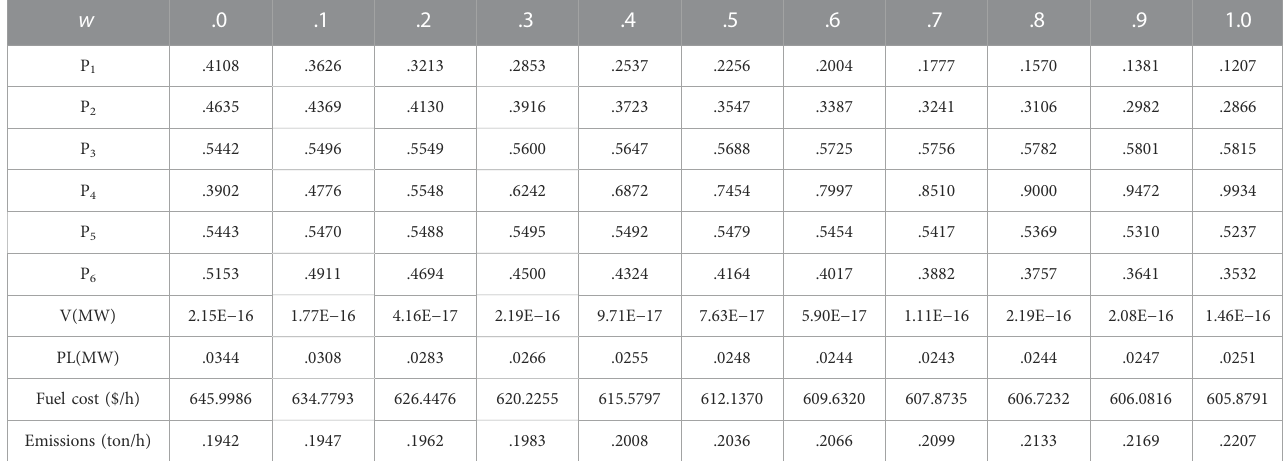
TABLE 5 Best solution values for a six-unit system with different weights. w .0 .1 P